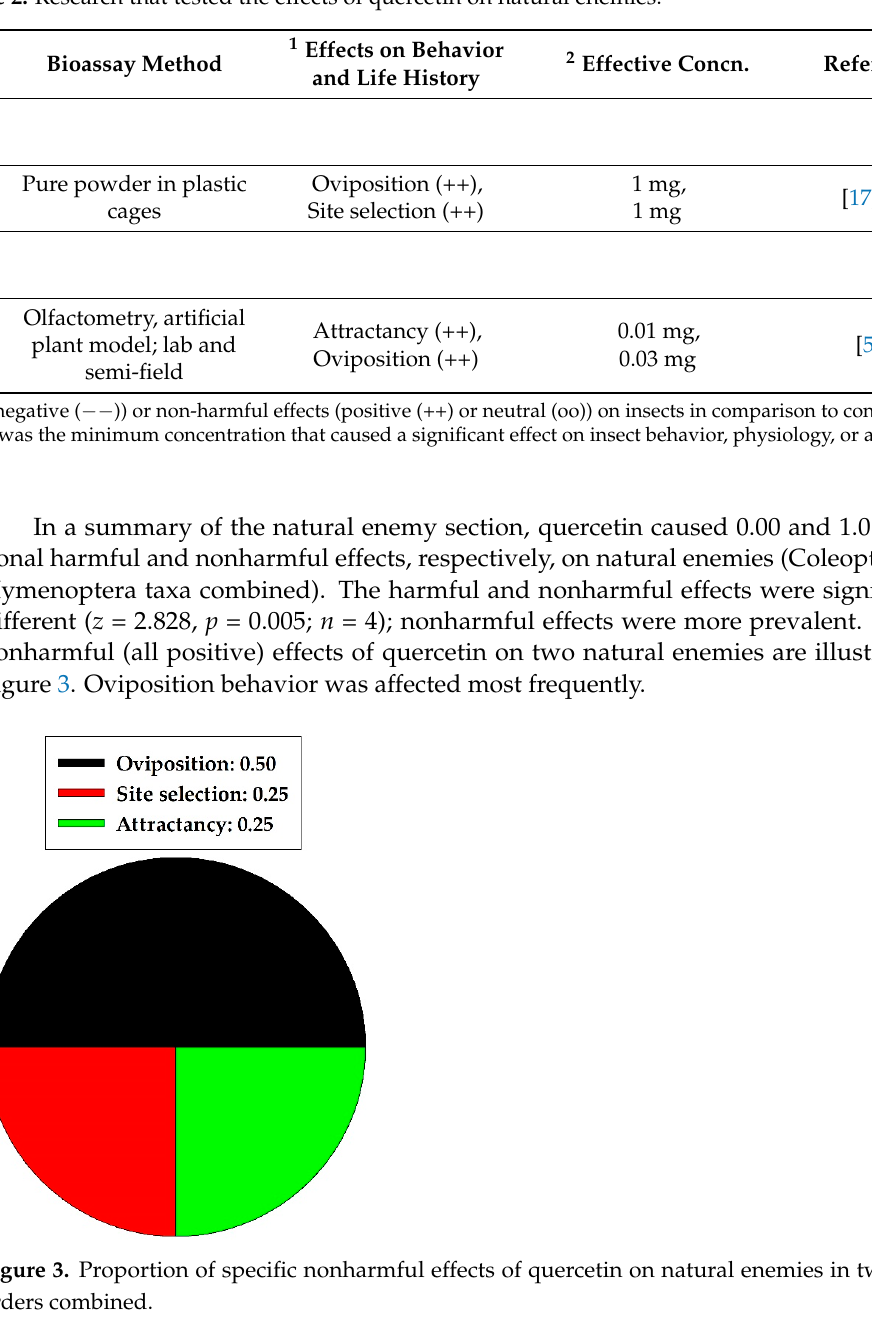
Table 2. Research that tested the effects of quercetin on natural enemies.